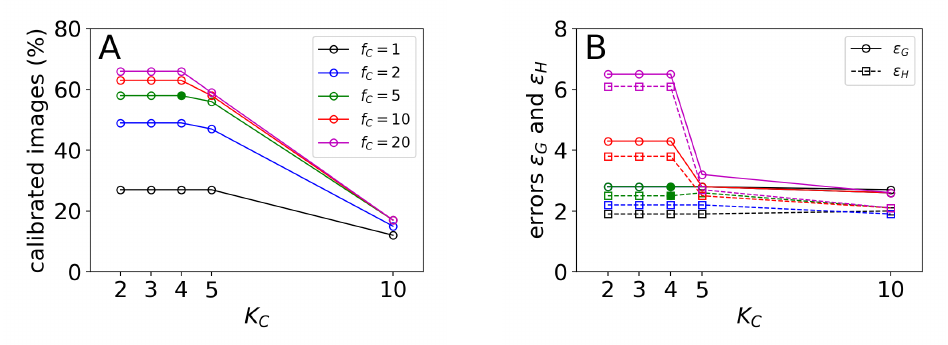
Figure 9. Station BCN1 for basis with n p = 4: percentage of automatic calibrations of control images so that f (cid:54) f C and K (cid:62) K C ( A ) and 95th percentile of ε G and ε H for automatic calibrations of the control images satisfying f (cid:54) f C and K (cid:62) K C ( B